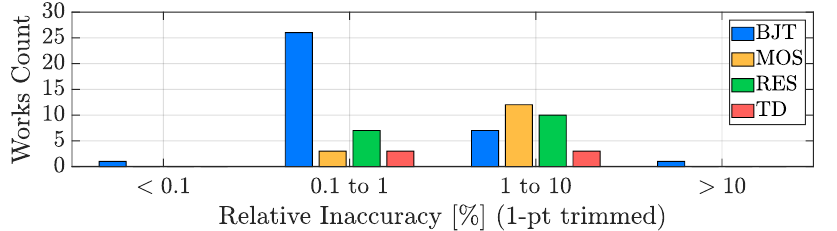
Figure 14. 1-pt trimmed TDC inaccuracy performance distribution with sensing-type distinction.